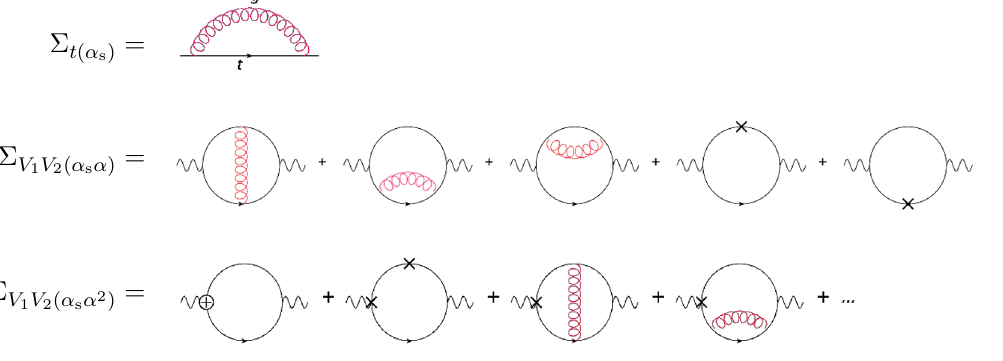
Figure 1 . Diagrams with closed fermion loops contributing to self-energies at different orders. V 1 and V 2 denote the possible different in- and outgoing gauge bosons. Vertices “ ⊕ ” and “ × ” indicate the counterterms at the loop order O ( α s α ) and O ( α ) or O ( α s ) , respectively. Note that there are no actual three-loop diagrams with two explicit closed fermion loops at the order O ( α s α 2 ) , but instead, all contributions stem from sub-loop counterterm